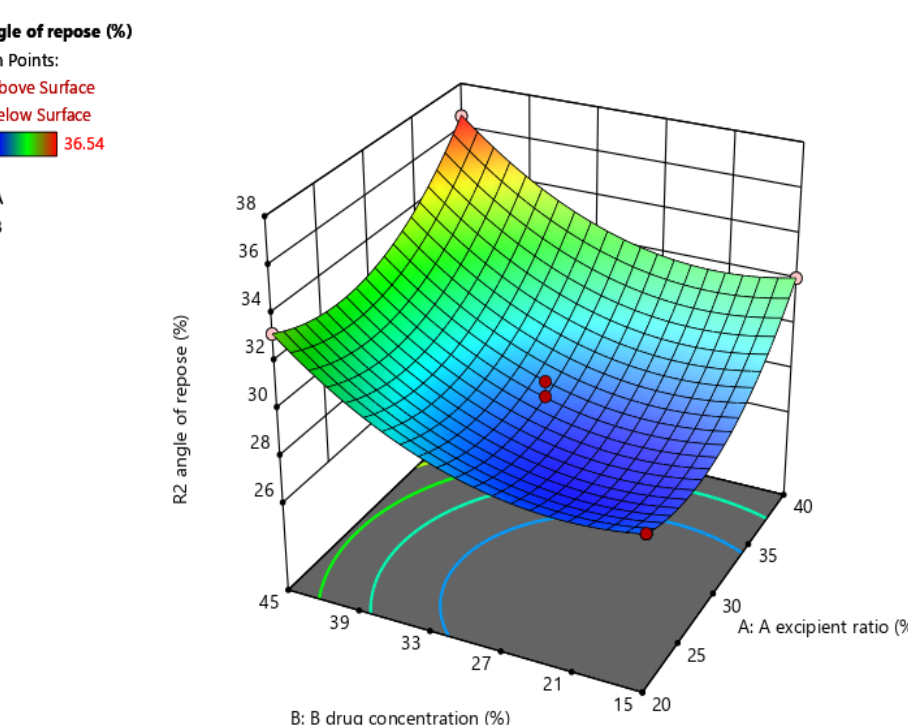
Figure 4. Surface response graph of in vitro dissolution of liquisolid compacts.